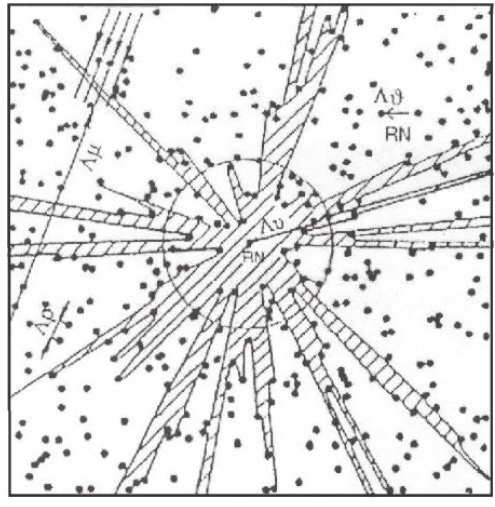
Fig. 7: Schematic illustration of interparticle